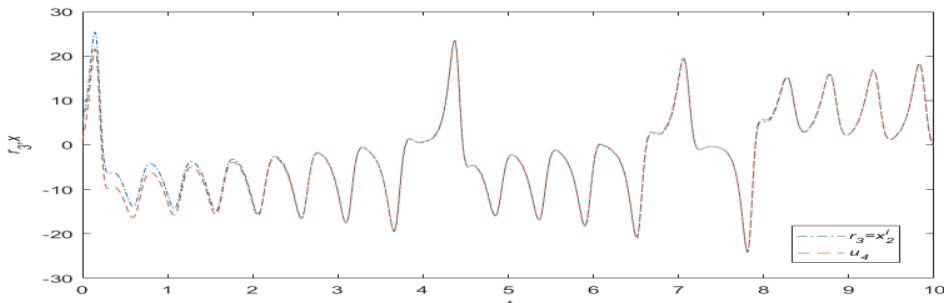
Figure 3. Tracking constant 5.